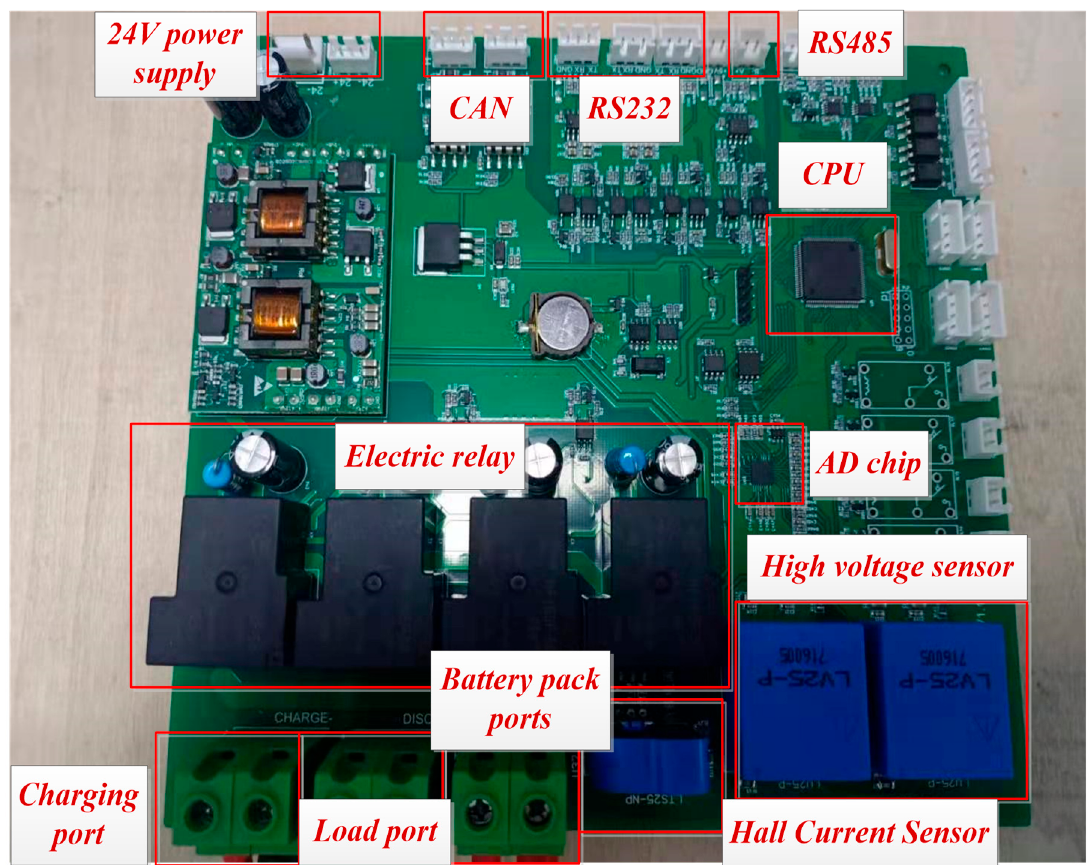
Figure 3. The hardware structure diagram of the main control board.